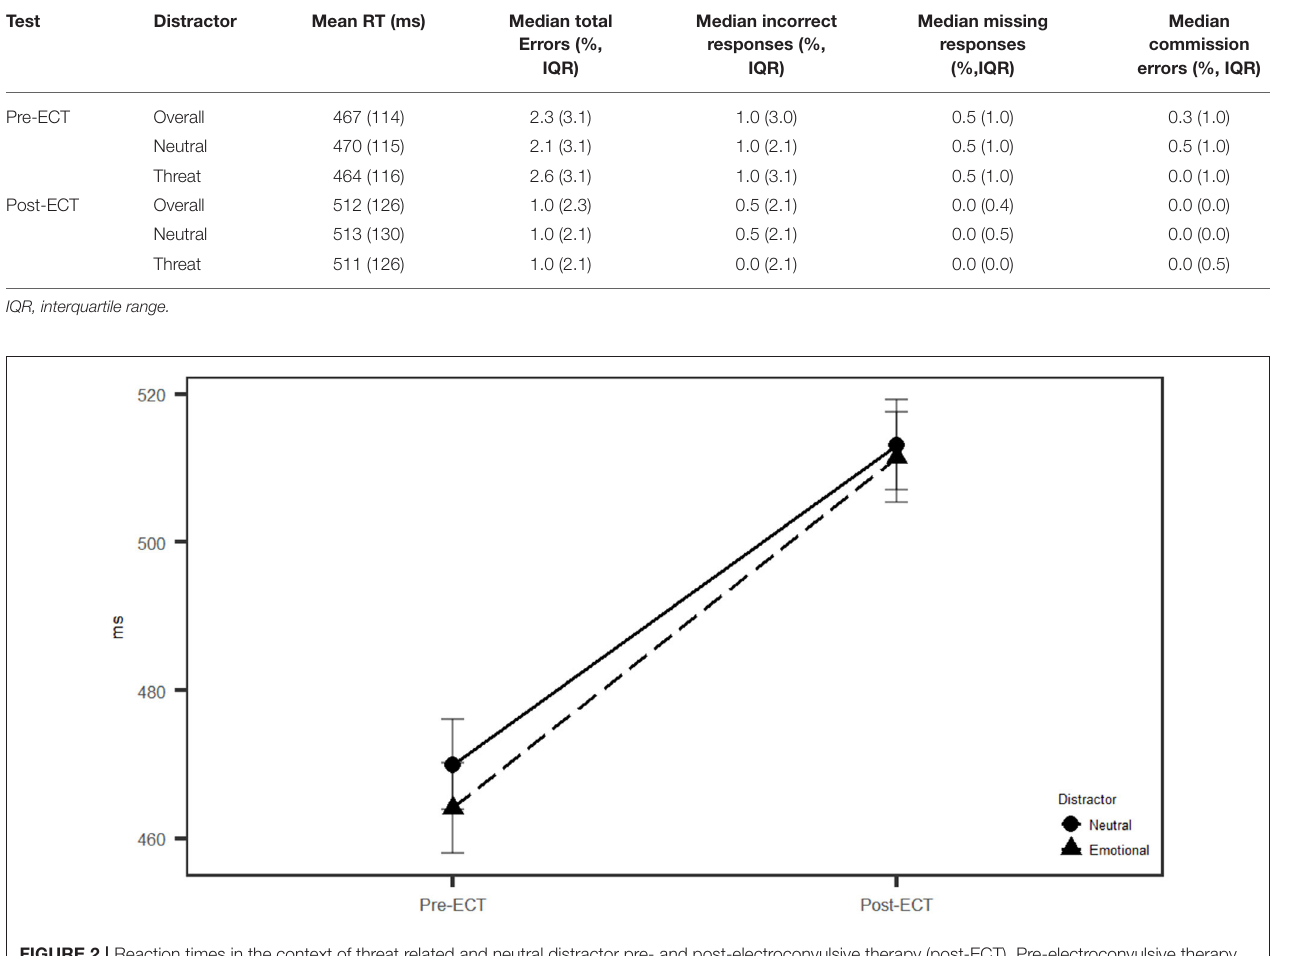
= 9.80, p = 0.006, η 2 = 0.00; threat post-ECT, 511 ± 126; neutral G post-ECT, 513 (130) ms, F (1, 16) = 0.02, p = 0.898, η 2